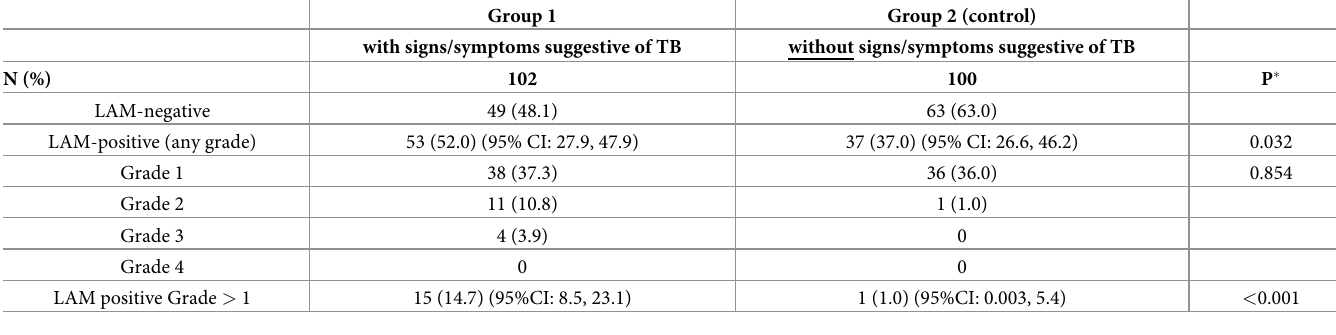
Table 3. TB LAM test results by study group. Group 1 Group 2 (control) with signs/symptoms suggestive of TB without signs/symptoms suggestive of